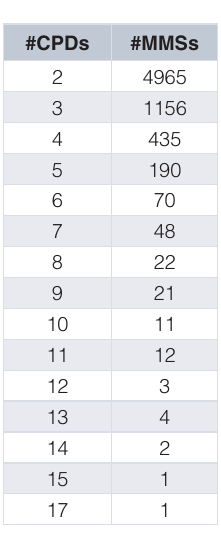
Table 1. Size distribution of matched molecular series (MMSs). The distribution of 6941 frequently active MMSs (#MMSs) over increasing numbers of compounds (#CPDs) is